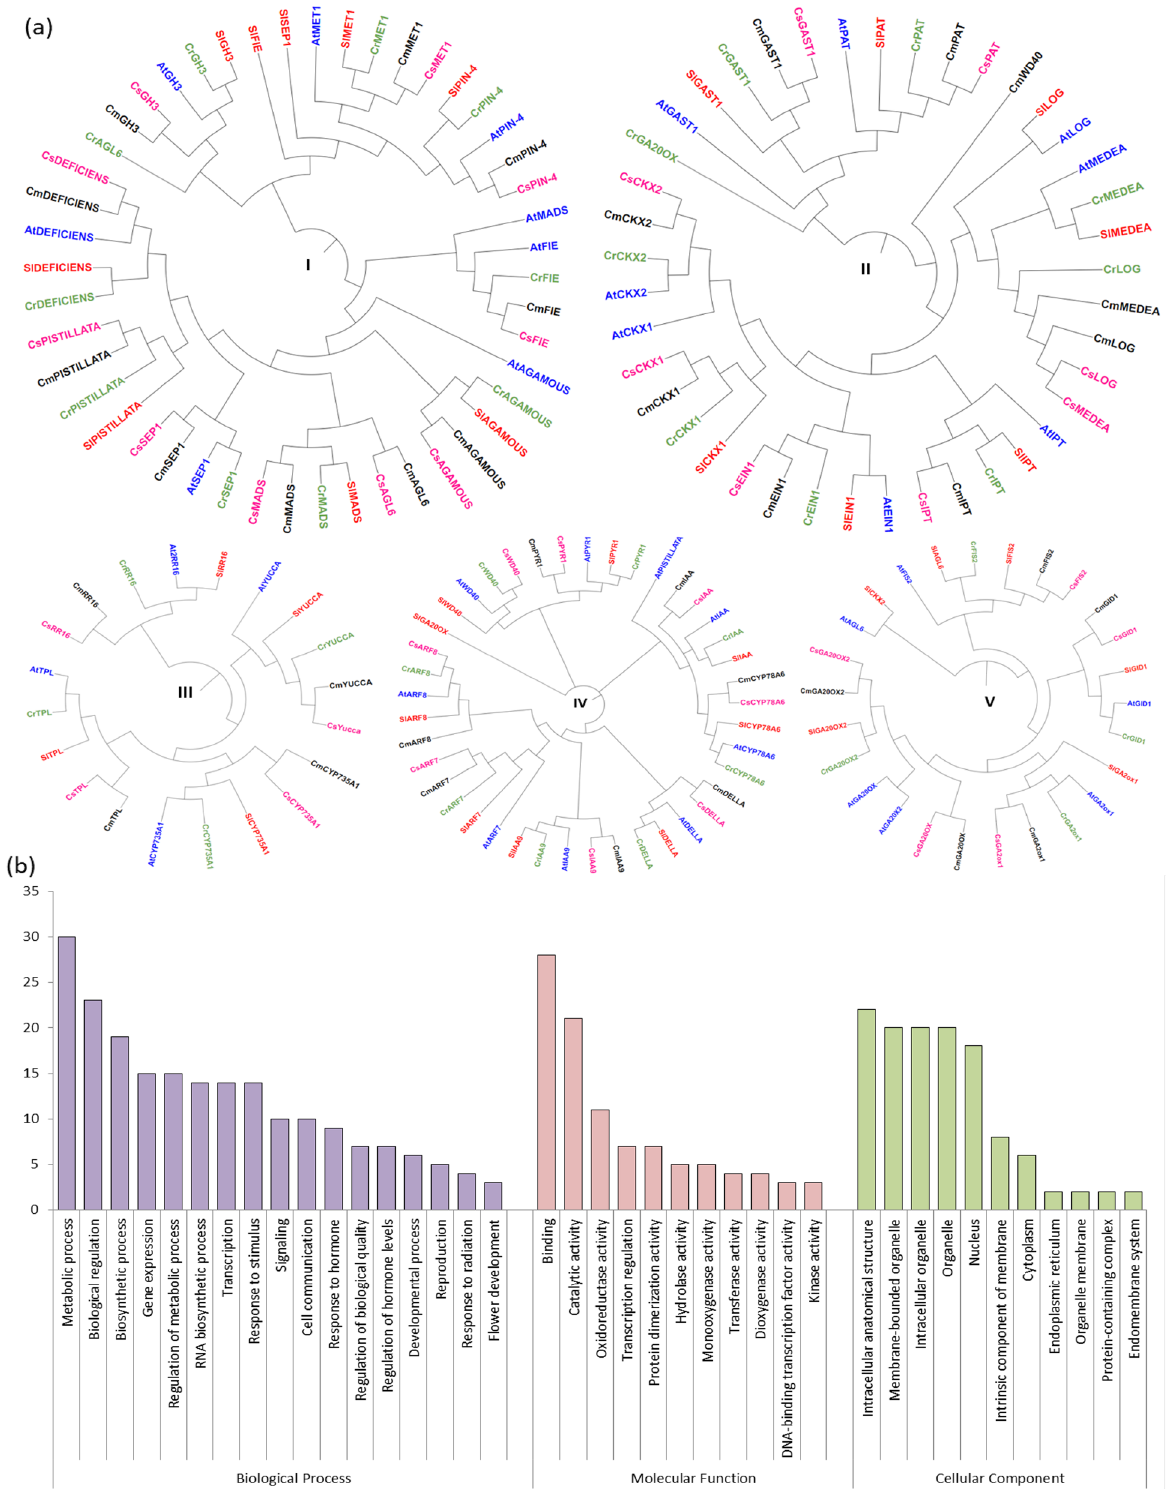
Figure 5. ( a ) Phylogenetic trees (homology groups I–V) showing relationship among 175 PRGs from Arabidopsis (At, blue), melon (Cm, black), citrus (Cr, green), cucumber (Cs, pink), and tomato (Sl, red) ( b ) Distribution of cucumber PRGs among three categories (cellular component, molecular functions and biological processes) via gene ontology